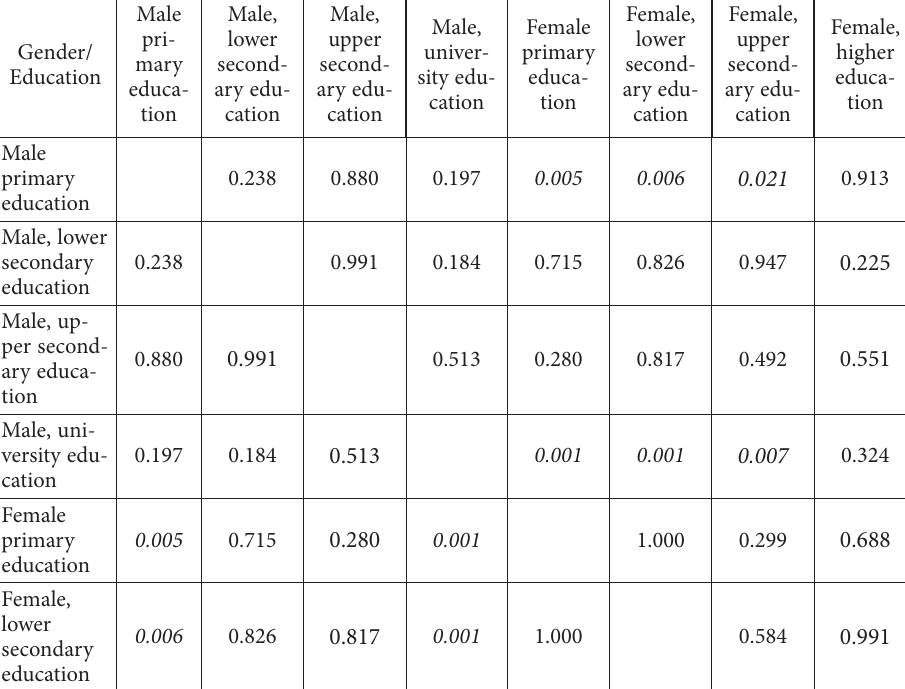
Table 7. Tukey´s HSD test results within motivational factors for base